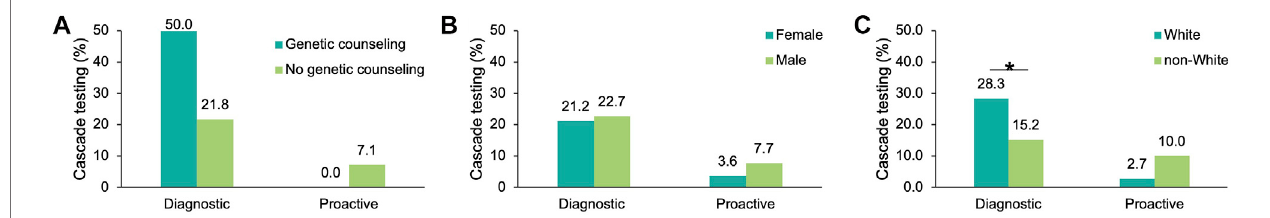
FIGURE 5 | Factors in fl uencing cascade testing rates among probands with a positive result in an FH gene. Cascade testing rates were calculated for probands with a positive fi nding in an FH gene and strati fi ed by characteristic: (A) Whether the proband had genetic counseling through Invitae, (B) Sex, and (C) Self-reported ancestry. FH, familial